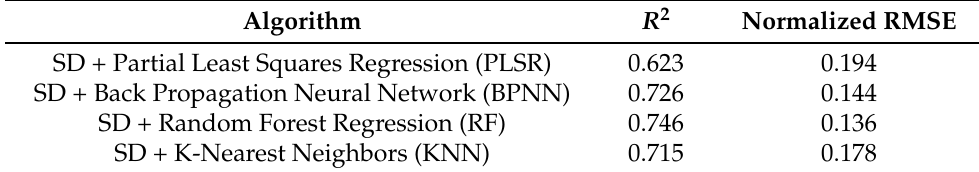
Figure 8. Scatter plots of the soil arsenic concentrations after the use of four different machine learning models with all 155 input wavelengths and SD transformation (SD+Reg models): PLSR (control group, ( a )), BPNN ( b ), RF ( c ), and KNN ( d ). Table 3. Table of the comparison of the R 2 and nRMSE values of the four regression-based machine learning algorithms tested for bare soil arsenic detection using all 155 wavelengths. Refer to the Abbreviations section at the end of the paper for full technique